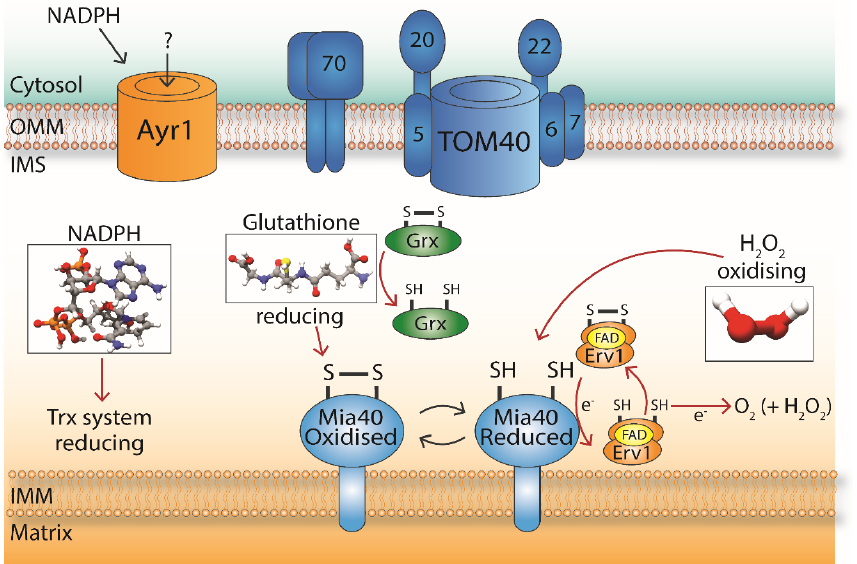
Figure 3. Small molecules affecting redox homeostasis in the IMS. Glutathione (GSH) has a reducing effect on Mia40/CHCHD4. H 2 O 2 has an oxidising effect on Mia40/CHCHD4 and can easily cross mitochondrial membranes. NADPH has a reducing effect on Mia40/CHCHD4 and is utilised by the two main thiol-reducing pathways in the cell, the Trx and Grx pathways. Cytosolic NADPH has recently been implicated in the regulation of the newly discovered OMM channel protein Ayr1, whose function remains unknown. Small molecule structures were obtained from PubChem and visualised in Chimera version 1.15.0. PubChem CIDs are as follows; NADPH (5884), glutathione (124886) and H 2 O 2